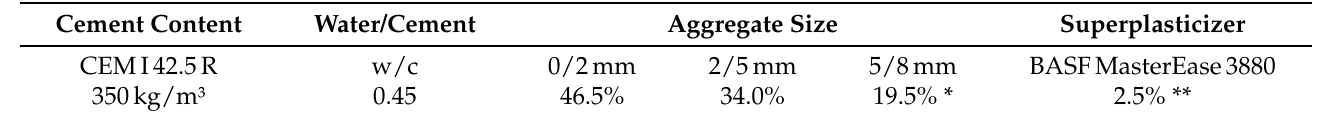
Table 1. Concrete raw materials and their composition for all experiments in this study, where the aggregates are primarily quartzitic and crushed.